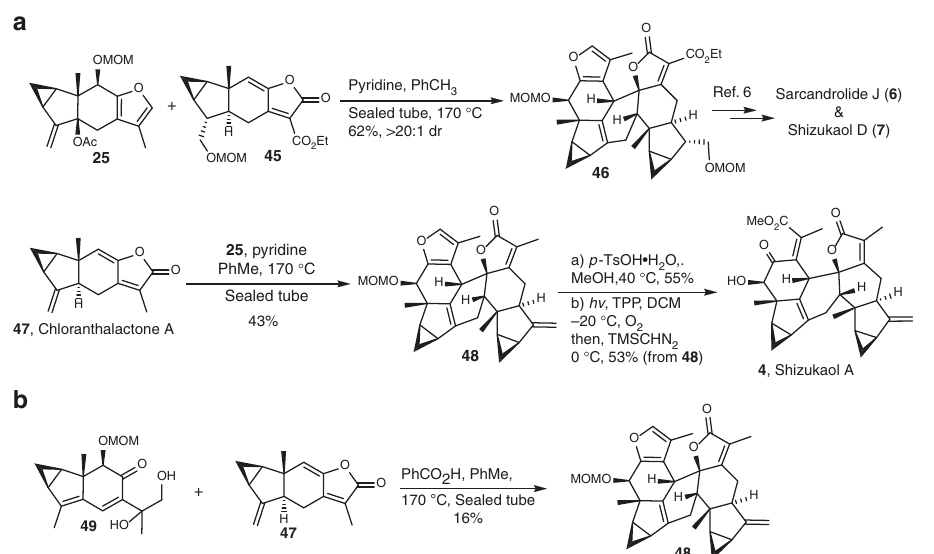
Fig. 6 Total syntheses of [4 + 2] lindenane dimers of types 1 and 2. a Sarcandrolide J, shizukaol D and shizukaol A can be synthesized through the [4 + 2] cycloaddition promoted by base. b The acid-mediated cycloaddition between 47 and 49 afforded 48 in inferior yield to that of the base-mediated cycloaddition between 25 and